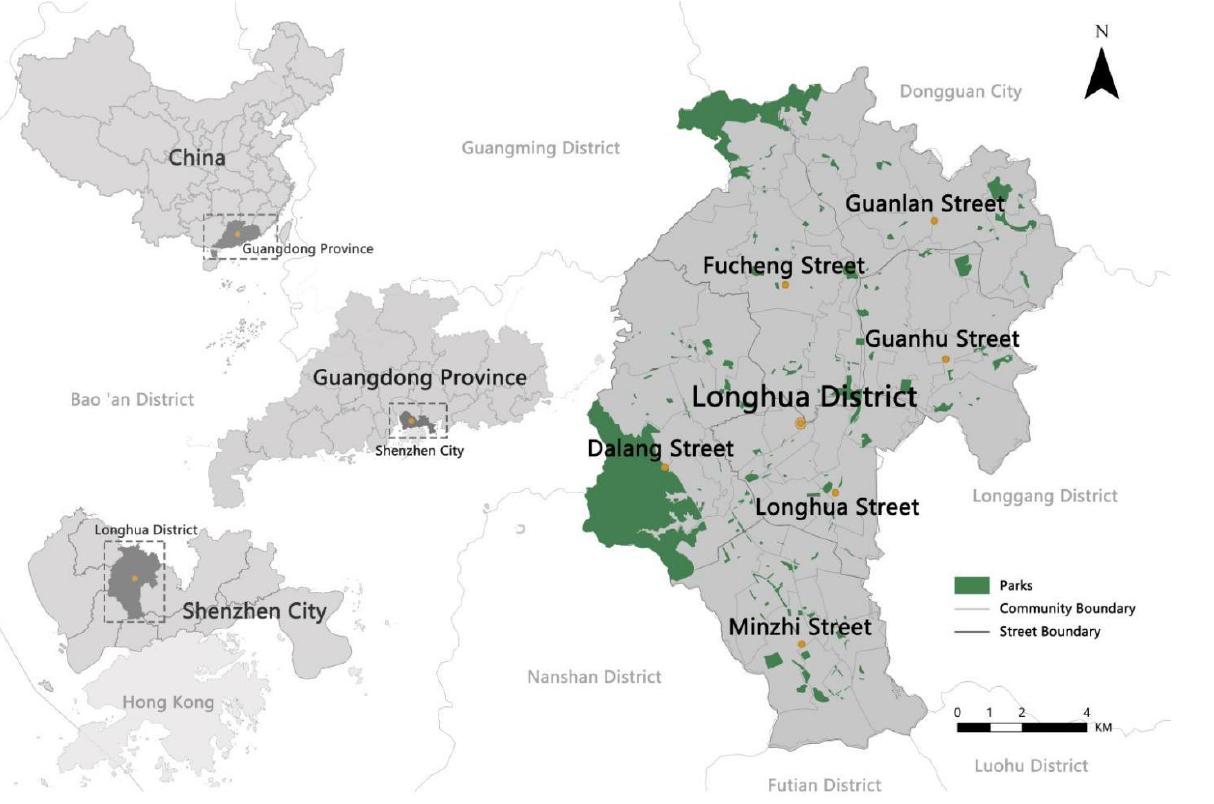
Figure 2. Study area.